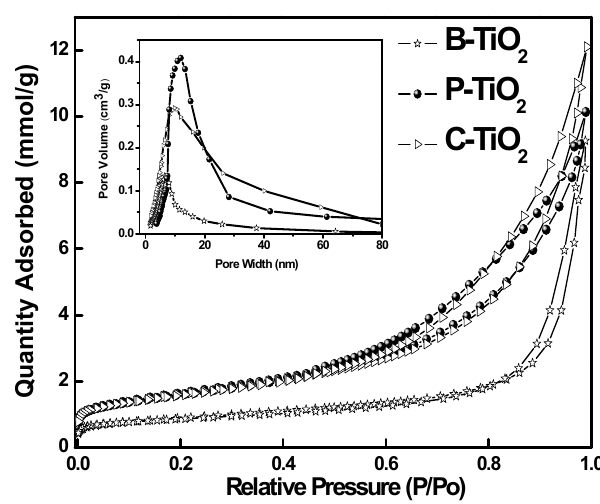
Table 1. Specific surface area, pore volume, and pore-size distribution of the samples. Sample Name